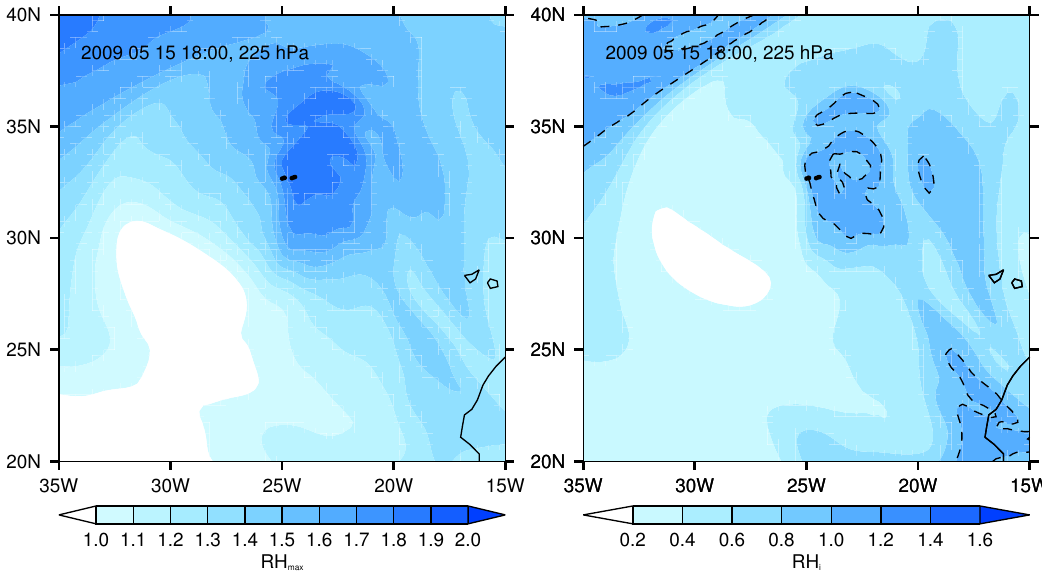
Figure 5. ( Left ): Field of RH max over a part of the Atlantic on 15 May 2009 at 18:00 UTC on the 225hPa pressure surface. The positions where contrails have been observed by ACTA between 17:40 and 18:30 are marked as black dots. RH max > 1 indicates that contrail formation is possible. ( Right ): The field of relative humidity with respect to ice for the same situation. The dashed line marks the transition between sub- to supersaturation.